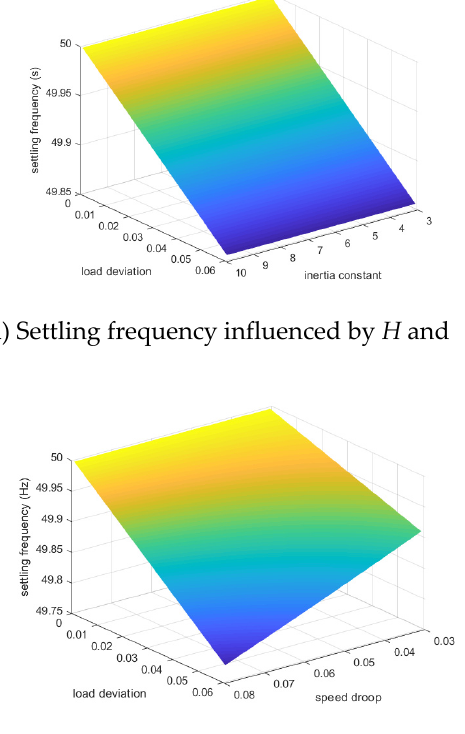
Figure 9. Composite influence on the peak frequency.